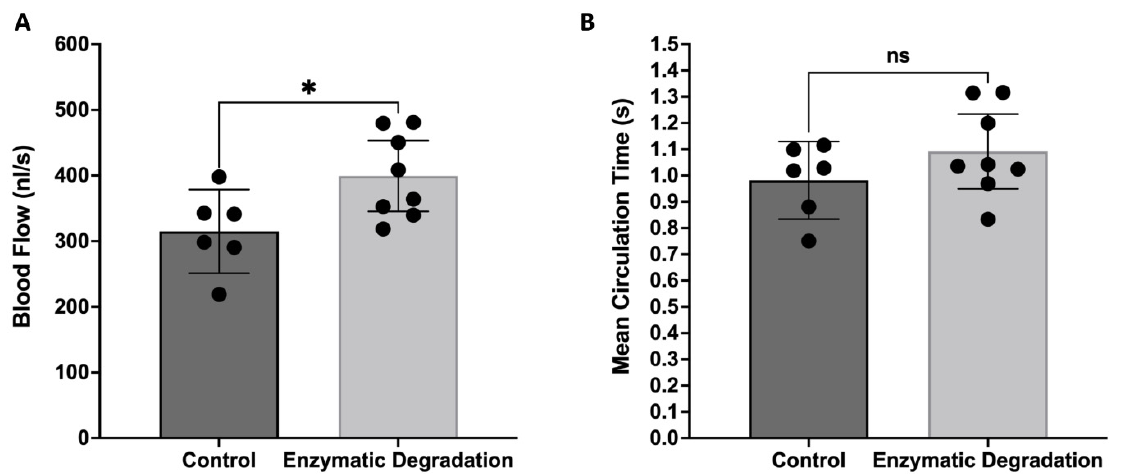
Figure 4. Effect of the Endothelial Glycocalyx on Retinal Blood Flow and MCT. ( A ) Total retinal blood flow and ( B ) mean circulation time through the retina in control mice (n = 6) and mice infused with glycocalyx-degrading enzymes (n = 8); means with 95% confidence intervals. * p < 0.05 and ns = nonsignificant.